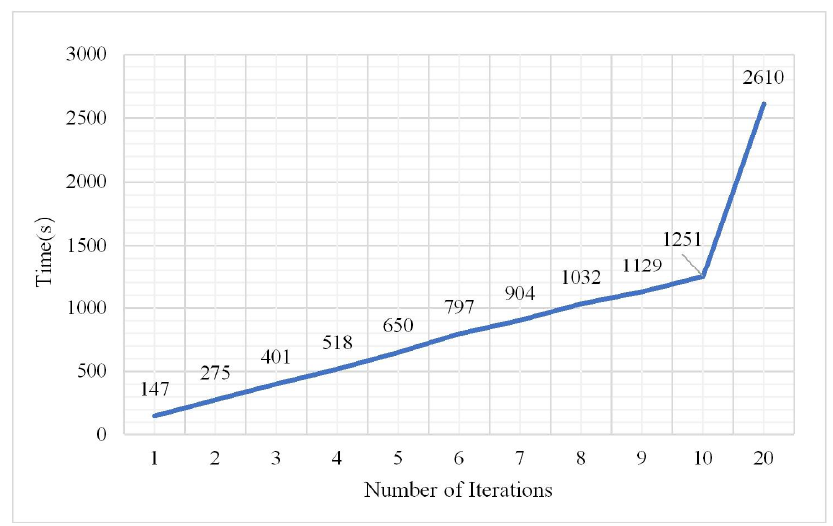
Plants 2021 , 10 , x FOR PEER REVIEW Figure 17. Change in kappa coefficient. Figure 17. Change in kappa coefficient.